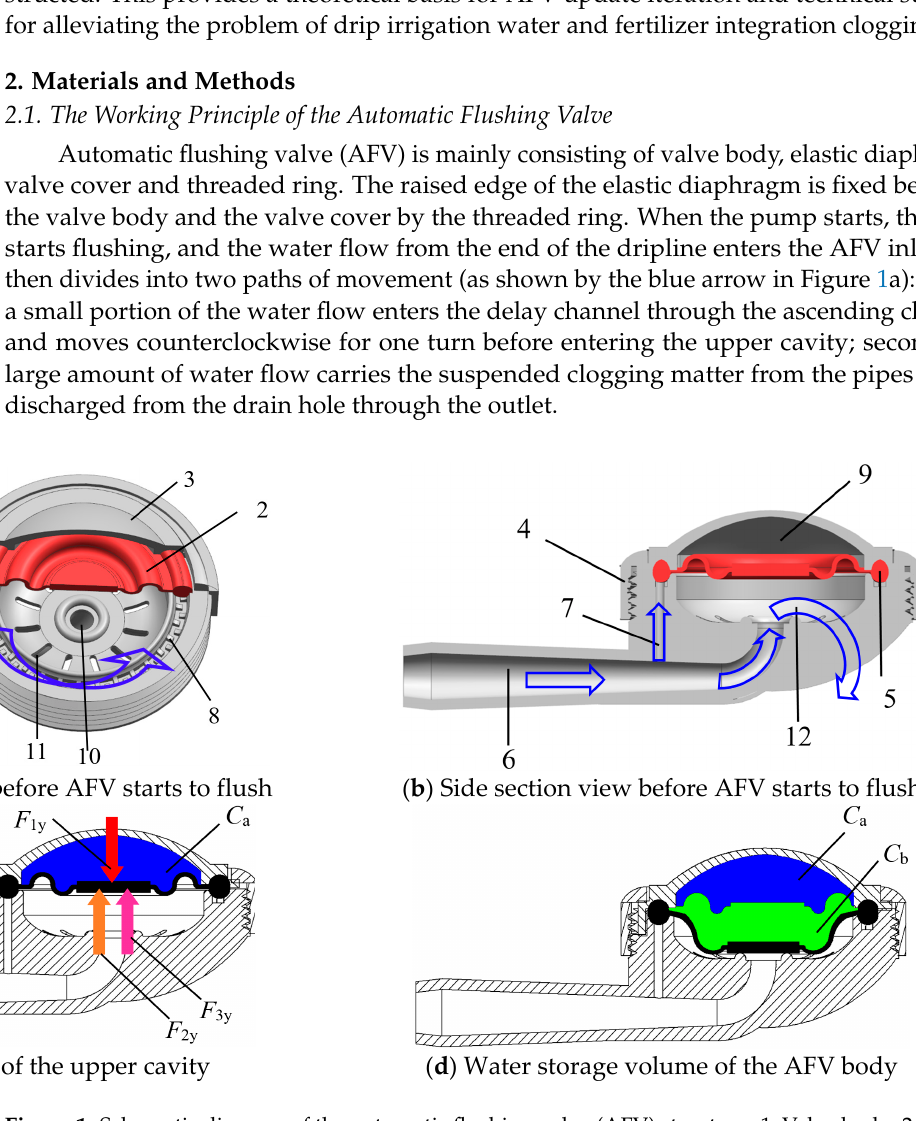
Figure 1. Schematic diagram of the automatic flushing valve (AFV) structure. 1. Valve body; 2. elastic diaphragm; 3. valve cover; 4. threaded ring; 5. raised edge of the elastic diaphragm; 6. water inlet; 7. ascending channel; 8. delay channel; 9. upper cavity; 10. outlet; 11. drain hole; and 12. lower cavity. Note: C a is the initial volume of the upper cavity, mL; C b is the volume added by the downwards movement of the elastic diaphragm, mL; F 1y is the downwards vertical force exerted by water in the upper cavity on the elastic diaphragm, N; F 2y is the vertical upwards force of water in the lower cavity on the elastic diaphragm, N; F 3y is the vertical elastic force of the elastic diaphragm, N; and the blue arrow is the direction of water movement.